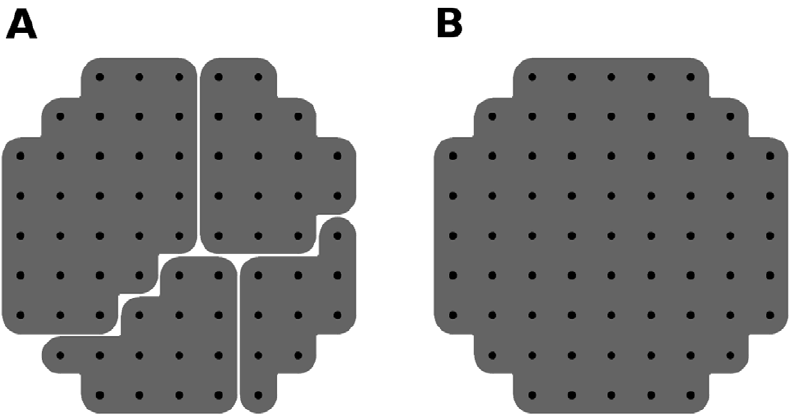
Figure 1. Calculation of clustering a set of points in a plane. (a) FastGroup’s method. (b) complete linkage clustering. Both of these clusterings are performed with the same radius r equal to the radius of the set of points. FastGroup constructs 4 clusters whereas complete linkage finds 1.